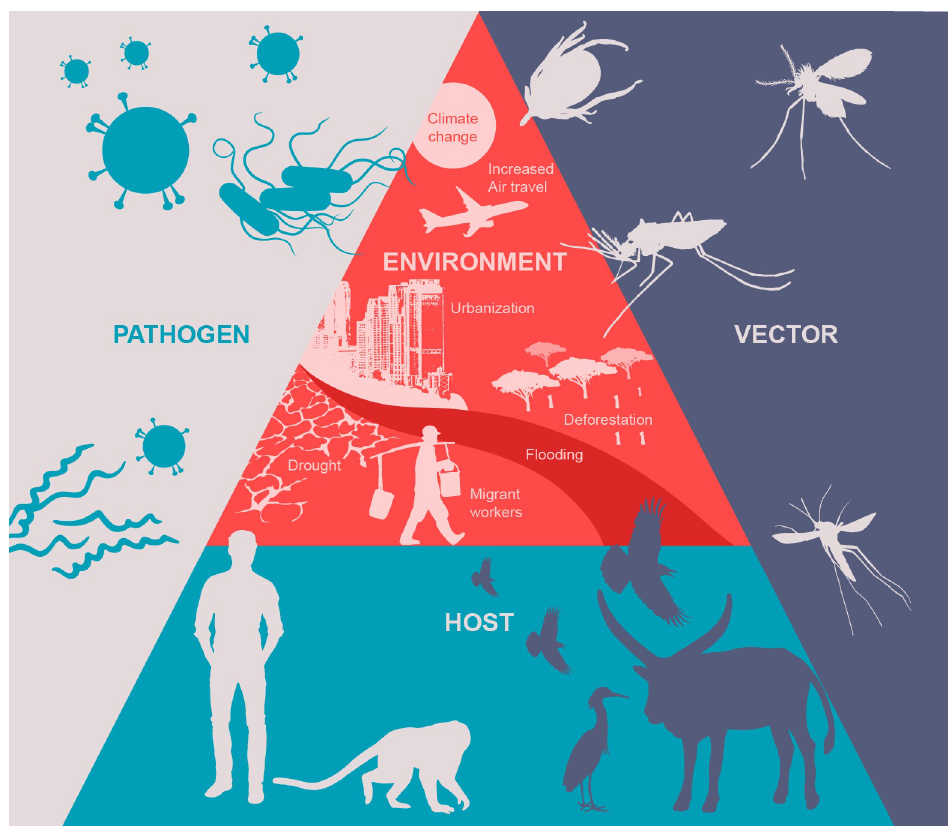
Fig 2. The pathogen–host–vector–environment interface representing the many factors that define